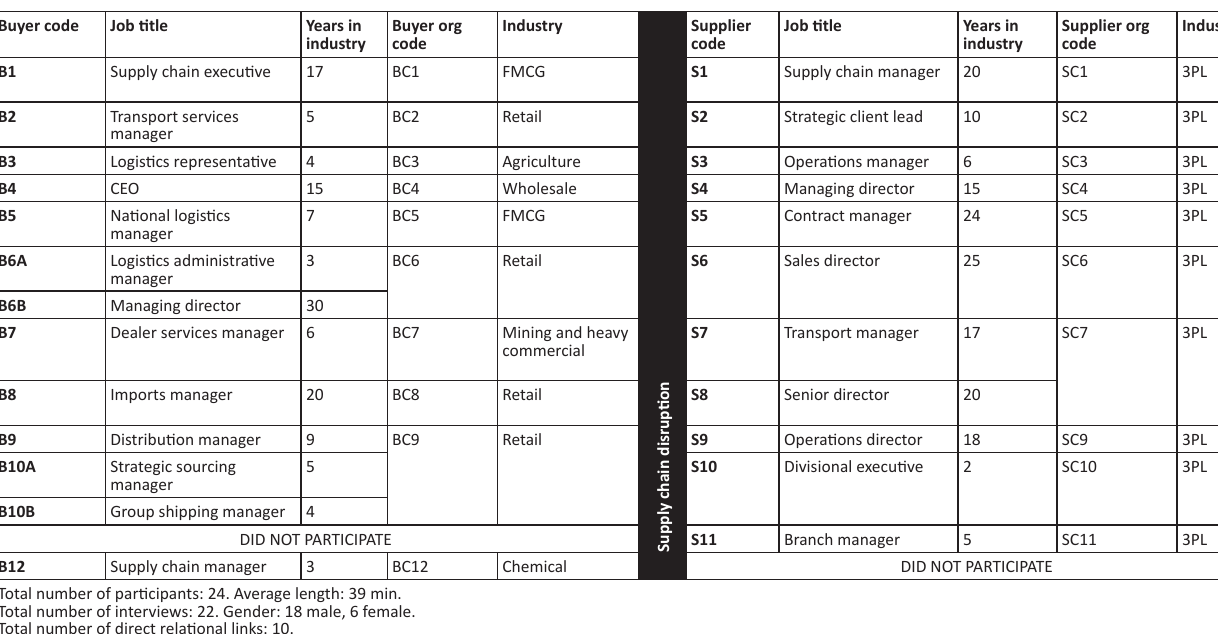
FIGURE 2: Participants’